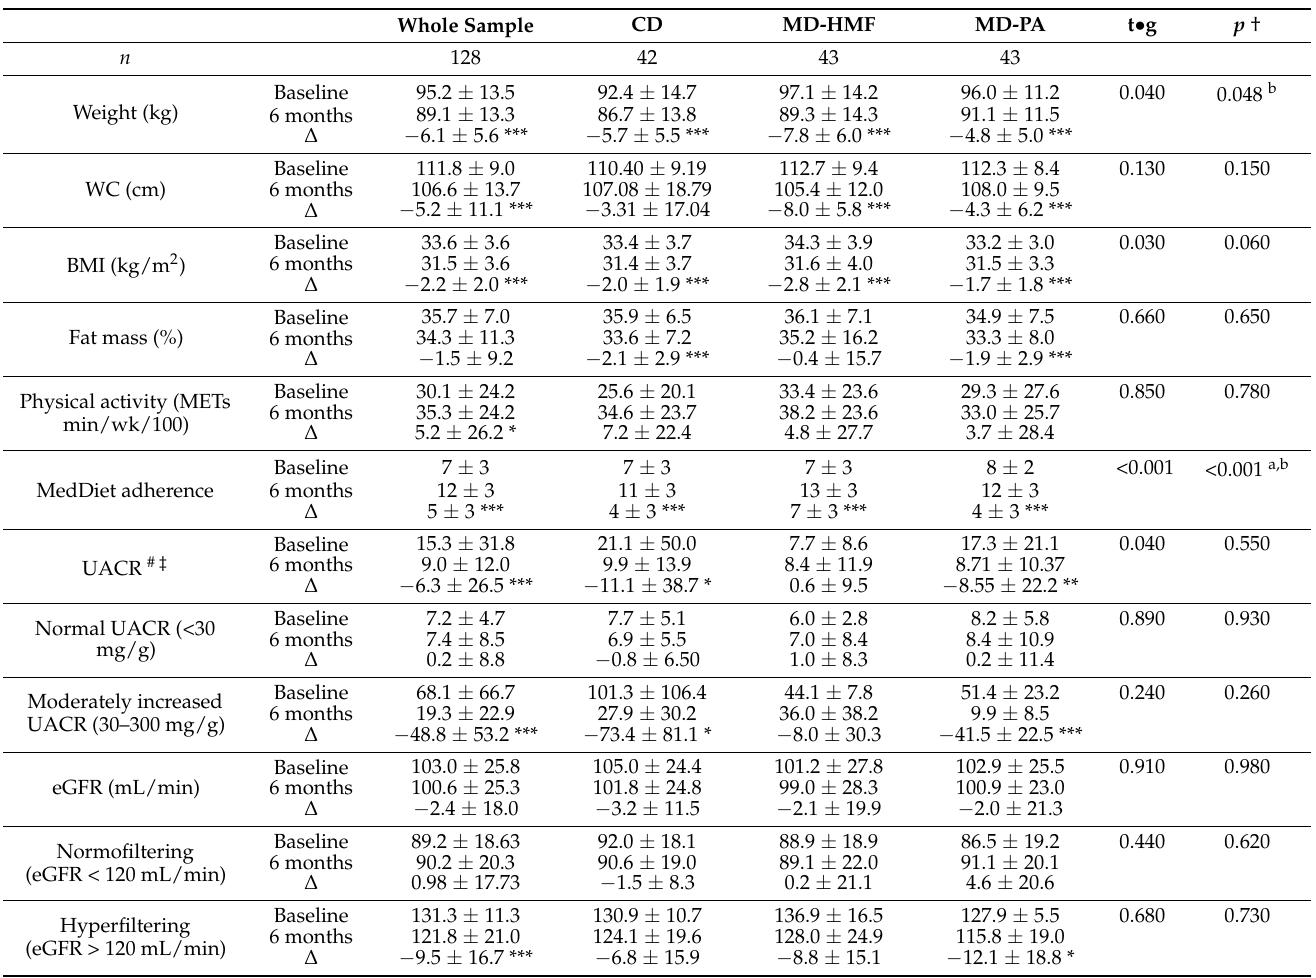
Table 2. Changes in anthropometrical, lifestyle, renal, and hepatic variables within and between intervention groups at 6 months versus